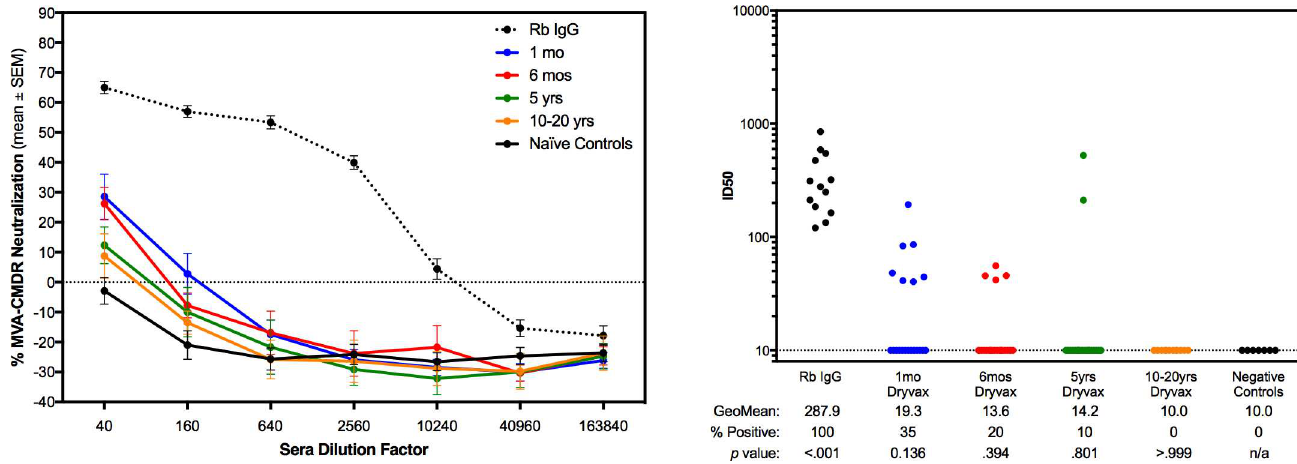
Fig 3. Neutralization of HIV transgene expressionfrom an MVA-vectored Phase 1 vaccine. (A) Neutralization curves for a randomlyselected subset (20%) of each of the testing groupsare shown as the mean ± SEM of all samples at each sera dilutiontested. (B) Curves were analyzedby non- linear regressionsigmoidaldose responsecurve fitting to determine the ID50 of each sample.Geometric mean and percent positive are indicatedfor each group. The p value was generatedby Mann-Whitney unpairedt-test of each group to the negative control (vaccinia-na ï ve) group.